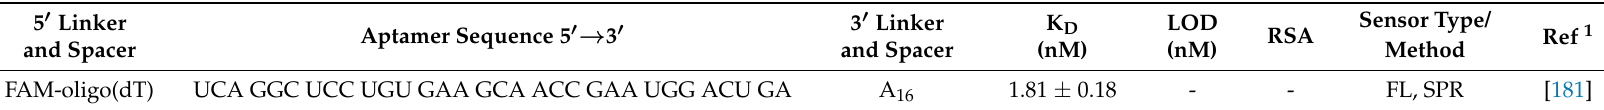
Table 11. Aptamer sequence, dissociation constant (K D ), limit of detection (LOD), real sample analysis (RSA), and realized sensor type and measuring method for danofloxacin, mentioned in the corresponding references (Ref). FAM = fluorescein amidite, FL = fluorometric, and SPR = surface plasmon